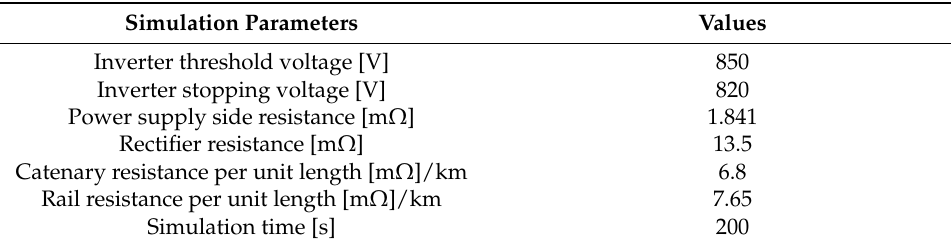
Figure 10. ( a ) TPS results for train power consumption between substation 10 and 12. ( b ) Speed data for Trains 1 to 4 between substation 10 and 12. Table 2. Simulation parameters for power analysis.